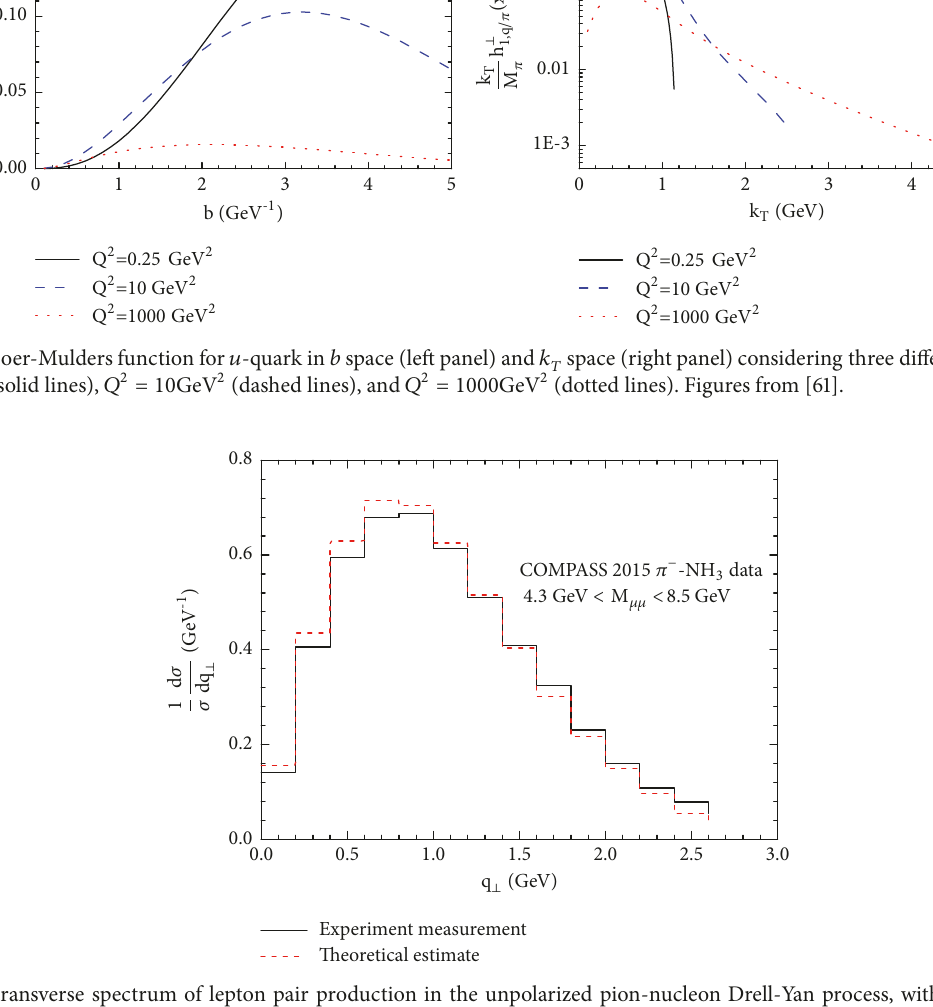
Figure 5: The transverse spectrum of lepton pair production in the unpolarized pion-nucleon Drell-Yan process, with an NH 3 target at COMPASS. The dashed line represents the theoretical calculation in [59]. The solid line shows the experimental measurement at COMPASS [11]. Figure from